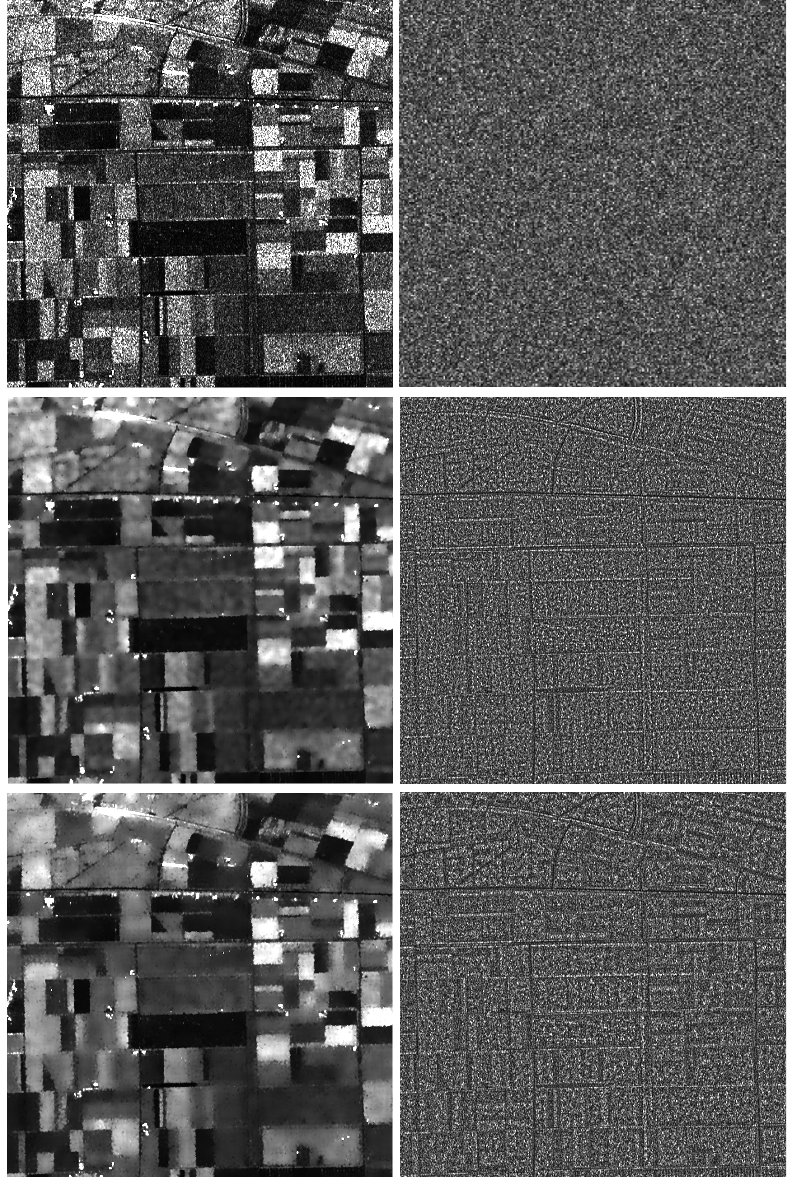
Figure 3. Examples of ratio images after filtering the observed data ( top ) with the same filter but with different designs. The ideal ratio image is also shown ( top right ). The filtered image by the enhanced Lee filter (7 7 mask size) is shown in the first row ( left ) and the ratio image in the same row ( right ). × The filtered image by the enhanced Lee filter (15 15 mask size) is shown in the second row ( left ) and × the ratio image in the same row ( right